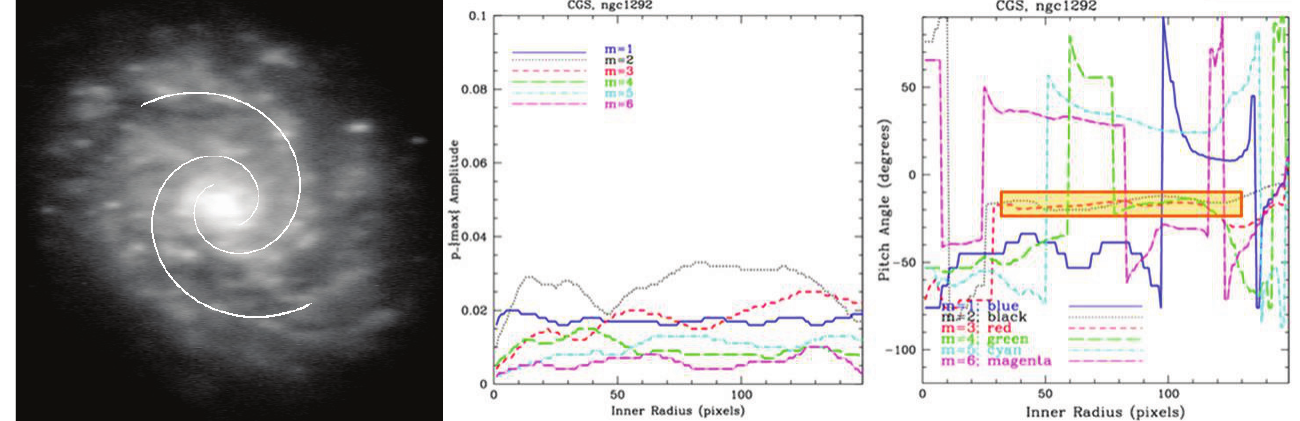
Figure 4. Example of spiral-arm pitch angle measurement for galaxy NGC 1292 using 2 DFFT . ( Left ) Deprojected galaxy image in the B -band, with the best-fit pitch model ( m = 2, φ = − 14. ◦ 87) overlaid. NB , we utilized the S PIRAL A RM C OUNT software [35,73] to overlay the best-fit pitch model output from 2 DFFT . Thus, the overlaid spiral is a representation of, and equivalent to, the inverse Fourier transform from 2 DFFT . ( Middle ) Amplitude of each Fourier mode, with the m = 2 symmetry ( ) being the most prominent for this galaxy. ( Right ) 2 DFFT results, with the user-selected region of stable pitch angle measurement highlighted with an orange rectangle, yielding φ = − 14. ◦ 87 ± 3. ◦ 37 for m = 2 ( ). NB , the stable region for the m = 2 mode also shows stability for some less dominant, higher orders of symmetry, in this case m = 3 and m = 4. The two-arm symmetry is distin- guishable in the image, though this flocculent galaxy blends the m = 2 spiral with arm segments in different symmetry configurations. Particularly, images with higher signal-to-noise ratios will exhibit higher levels of agreement among multiple harmonic modes. Moreover, there will be less confusion over the chirality (i.e., clockwise or counterclockwise winding) of the galaxy. By visual inspection of the image in the left panel, we can safely ignore all of the positive pitch angle measurements displayed in the right